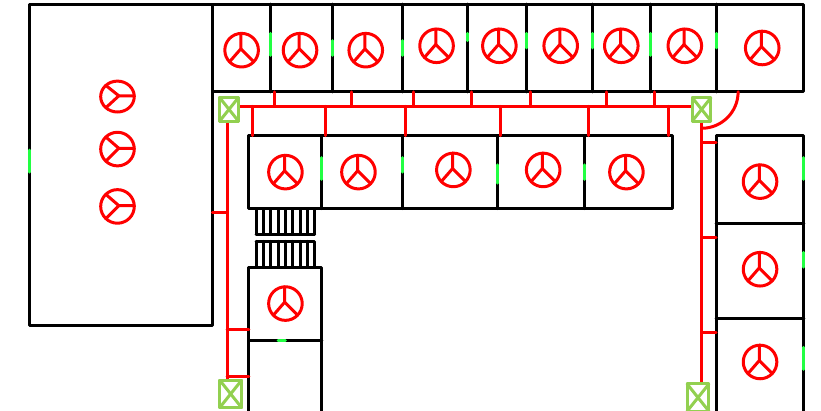
Figure 12. Faqir API Hostel (ground floor)